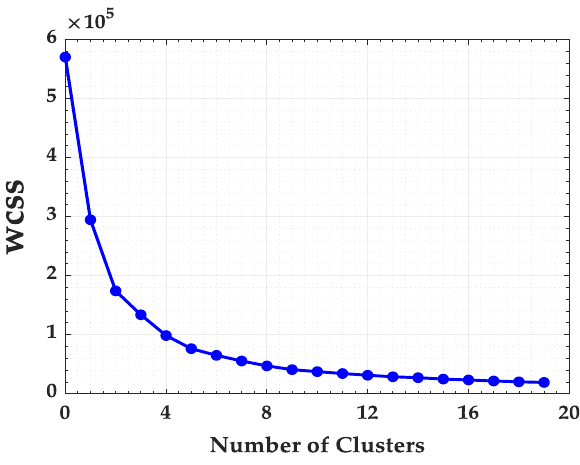
Figure 13. Within Cluster Sum of Squares (WCSS) for Mato Grosso